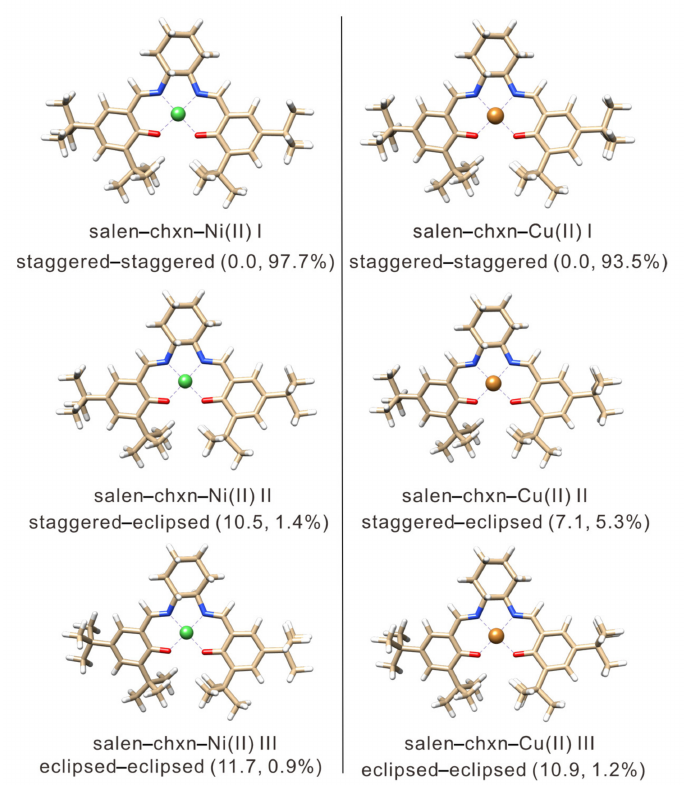
Figure 3. The optimized geometries of the salen-chxn-Ni(II) and salen-chxn-Cu(II) conformers at